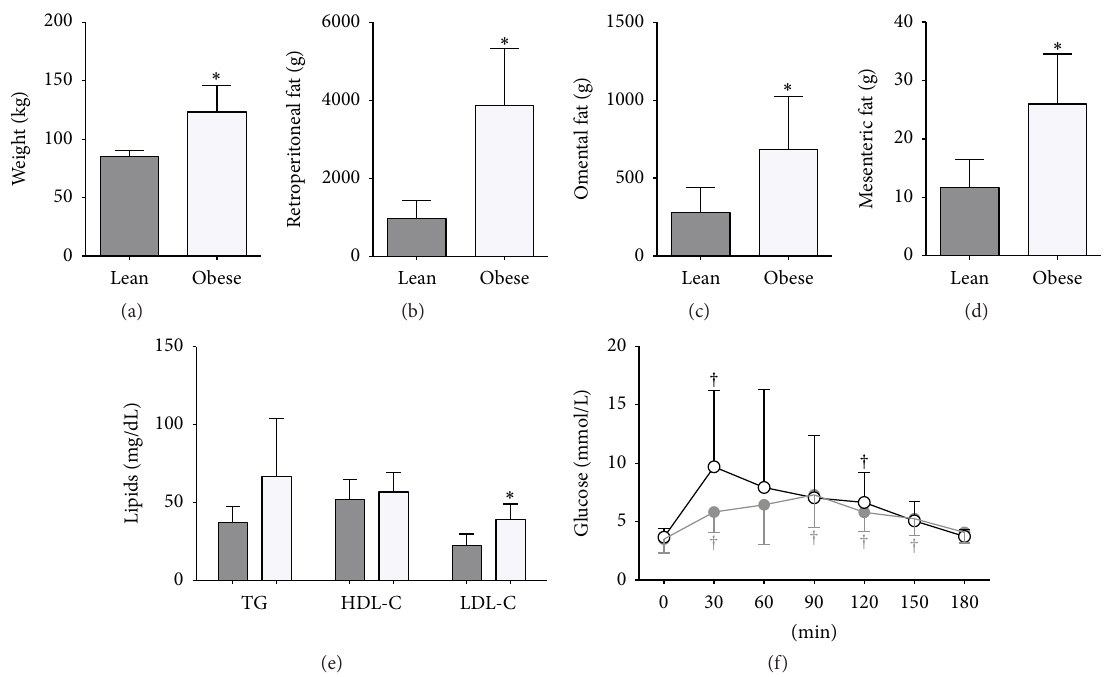
Figure 1: Anthropometric and metabolic characteristics in the lean group of animals ( 𝑛 = 8 , grey columns and line) and in the obese group of animals ( 𝑛 = 10 , open columns and a black line). The animals were weighted before slaughter (a), and after slaughter the weight of the retroperitoneal fat (b), omental fat (c), and mesenteric fat (d) was measured. Triglycerides (TG), high-density lipoprotein (HDL-C), and low-density lipoprotein (LDL-C) were measured from plasma collected after an overnight fast (e). Oral glucose tolerance test (OGTT) was performed only on males (7 in each group) after an overnight fast, and blood glucose was measured every 30 min for 3 hours (f). Data are mean ± SD. ∗ 𝑝 < 0.05 compared to lean. † 𝑝 < 0.05 compared to